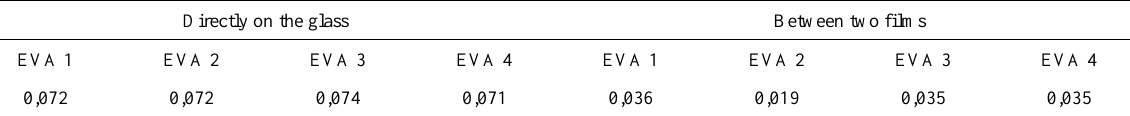
Table 7: Average luminescence of the samples with liquid paint applied with a brush (lux) Directly on the glass